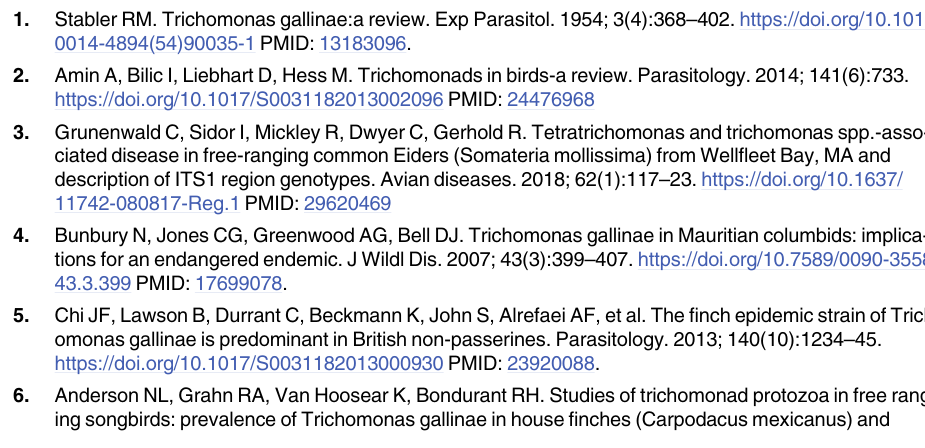
S1 Fig. Agarose Gel Electrophoresis of the PCR product of isolates of T . gallinae .